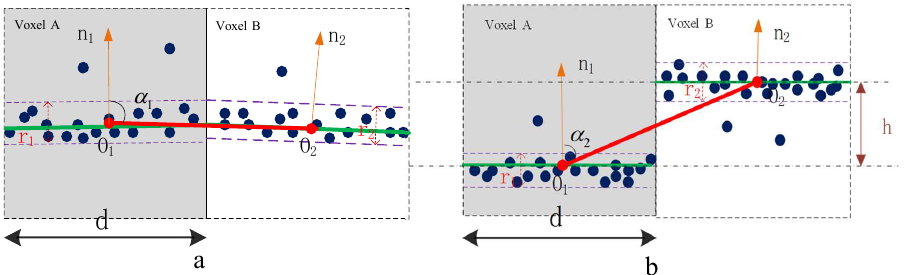
→ → O 1 O 2 · N 1 < ϕ th   → →  O 1 O 2 · N 1 > ϕ th .    .